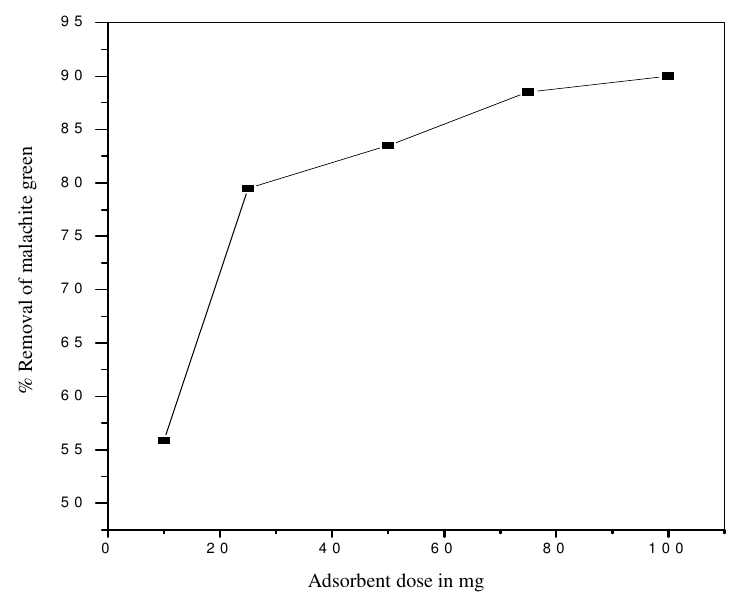
Figure 1. Effect of adsorbent dose on the removal of malachite green [M] = 30 mg/L; contact time = 60 min; temp = 35 o C Table 2. Equilibrium parameters for the adsorption of malachite green onto activated carbon C e , mg/L Q e , mg/g Dye removed, % [MG] 0 Temperature,